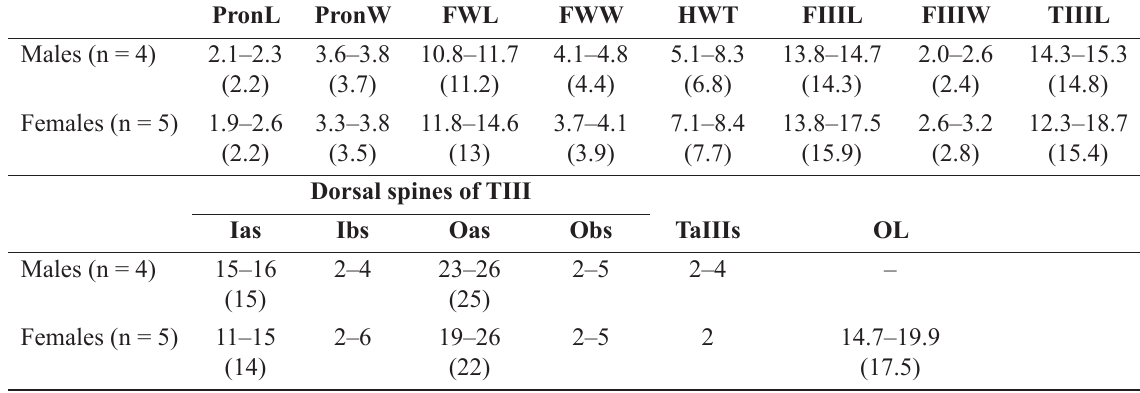
Table 3. Measurements of Nisitrus brunnerianus Saussure, 1878 (in mm, means in